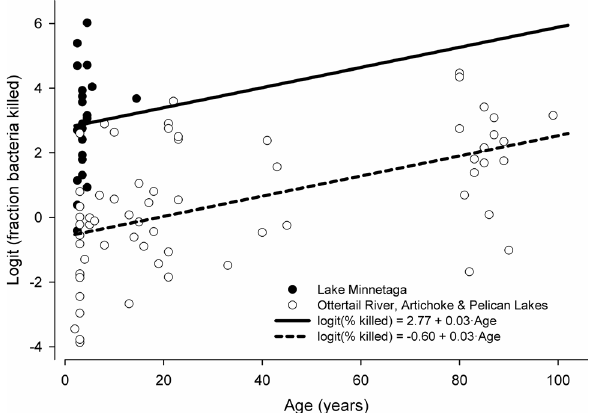
Figure 3. The relationship between age and bacterial killing capacity (logit-transformed) in bigmouth buffalo ( Ictiobus cyprinellus ) from Lake Minnetaga (filled circles, solid line) and Artichoke Lake, Ottertail River and Pelican Lakes (open circles, dashed line) with regression lines from the post hoc model with additive effect of site and age. Bacterial killing capacity significantly increased with age (F 1,85 = 23.29, p < 0.01, r 2 = 0.17).